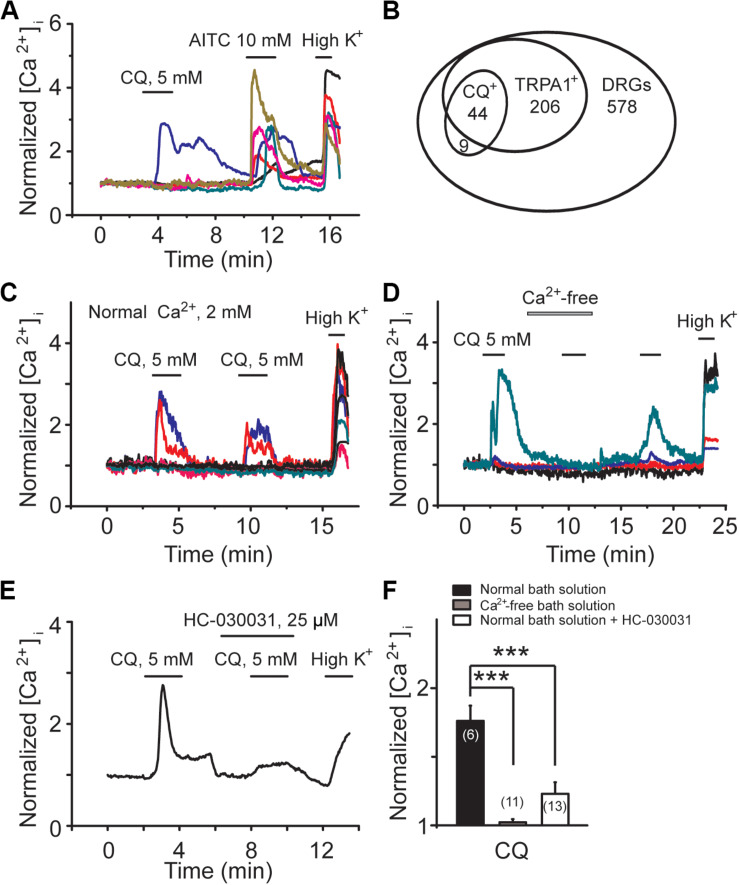
CQ increases intracellular Ca2+ through TRPA1-mediated Ca2+ influx in mice DRG neurons. (A) Representative traces from six different DRG neurons with calcium-imaging assay. Allyl isothiocyanate (AITC, 10 mM)-responsive DRG neurons indicate TRPA1-positive neurons. (B) The Venn diagram illustrates the relationships of CQ-, AITC (TRPA1+)-responsive neurons in adult DRG. The sizes of the circles are proportional to the sizes of the cell populations. CQ can increase intracellular Ca2+ in the presence (C) but not in the absence (D) of extracellular Ca2+ (2 mM). (E) Selective inhibition of TRPA1 by HC-030031 reduces CQ-induced increase of intracellular Ca2+. (F) Summary data of CQ-induced increase of intracellular Ca2+ in normal bath solution, Ca2+-free solution, and normal bath solution contained HC-030031, respectively. Data are shown as mean ± SEM (the n number in each group is indicated). The statistical significance was evaluated using Student’s t-test for comparison between two groups. ***p < 0.001.